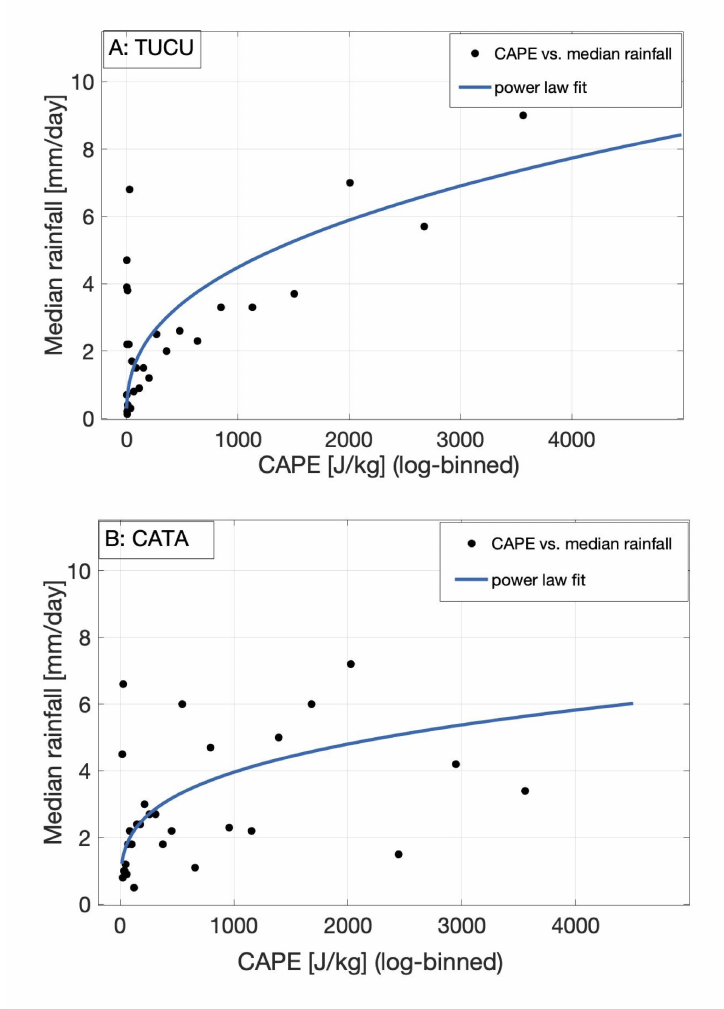
Figure 8. The logarithmically binned CAPE vs. median rainfall ( A ) for TUCU and ( B ) for CATA. The exponent β in (Equation (4)) is 0.38 for TUCU and 0.3 for